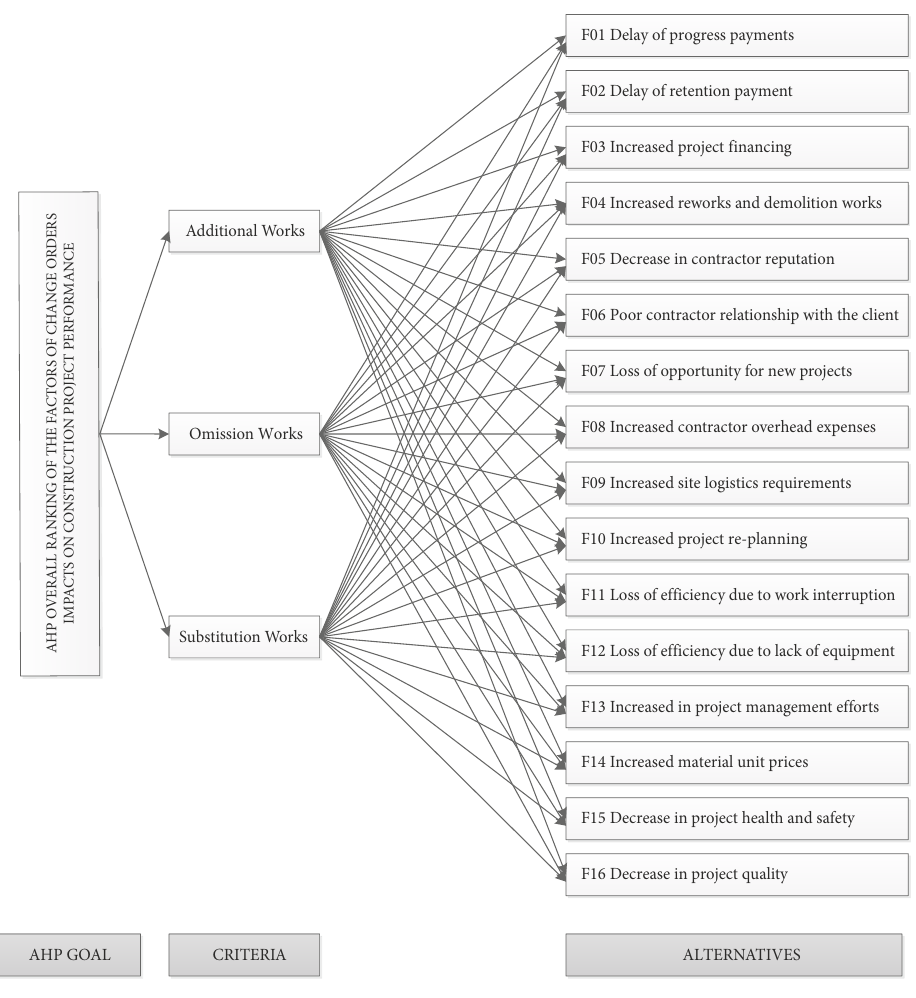
Figure 3. Model for AHP overall ranking (All 3 change